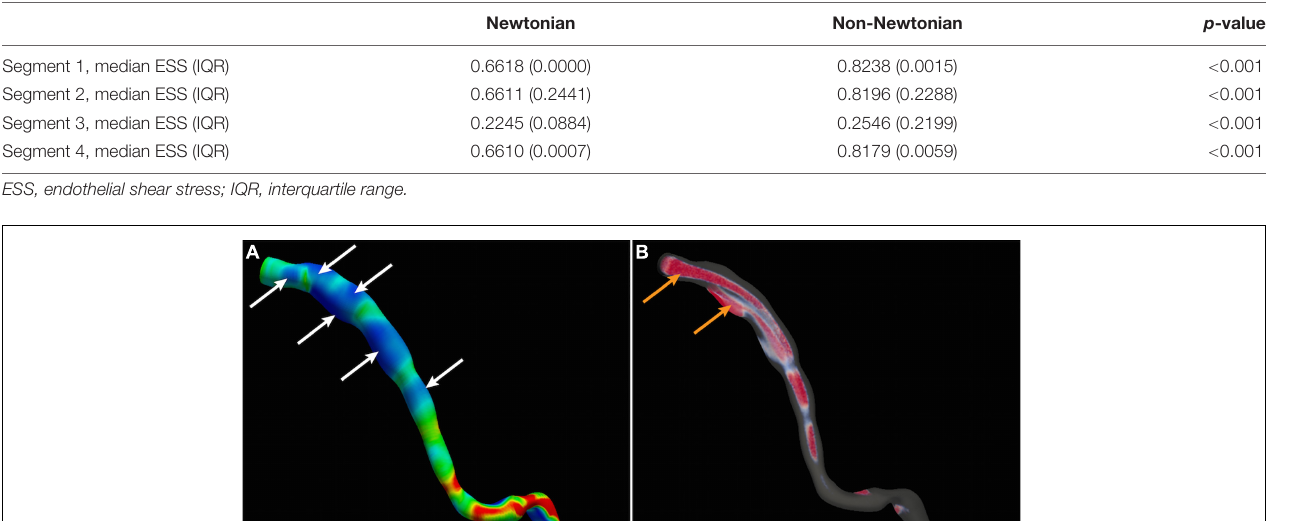
(2) the Newtonian model shows significantly greater vessel areas exposed to atherogenic low ESS; (3) OSI is not significantly different between the models; and (4) the non-Newtonian model identifies regions of high LBV up to 70-fold higher than that assumed by the Newtonian